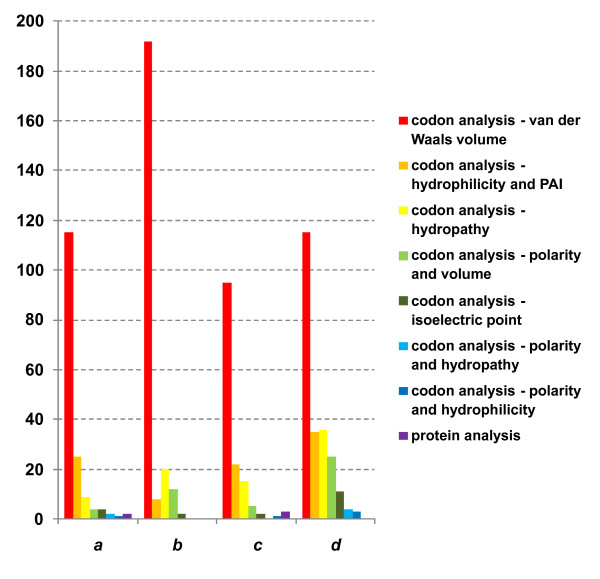
Number of gene clusters for which positive selection was detected by different approaches and different amino acid physicochemical categorizations. The bar colors for different approaches are shown on the right; y-axis: number of clusters; x-axis: branches (designations are as in Figure 2).